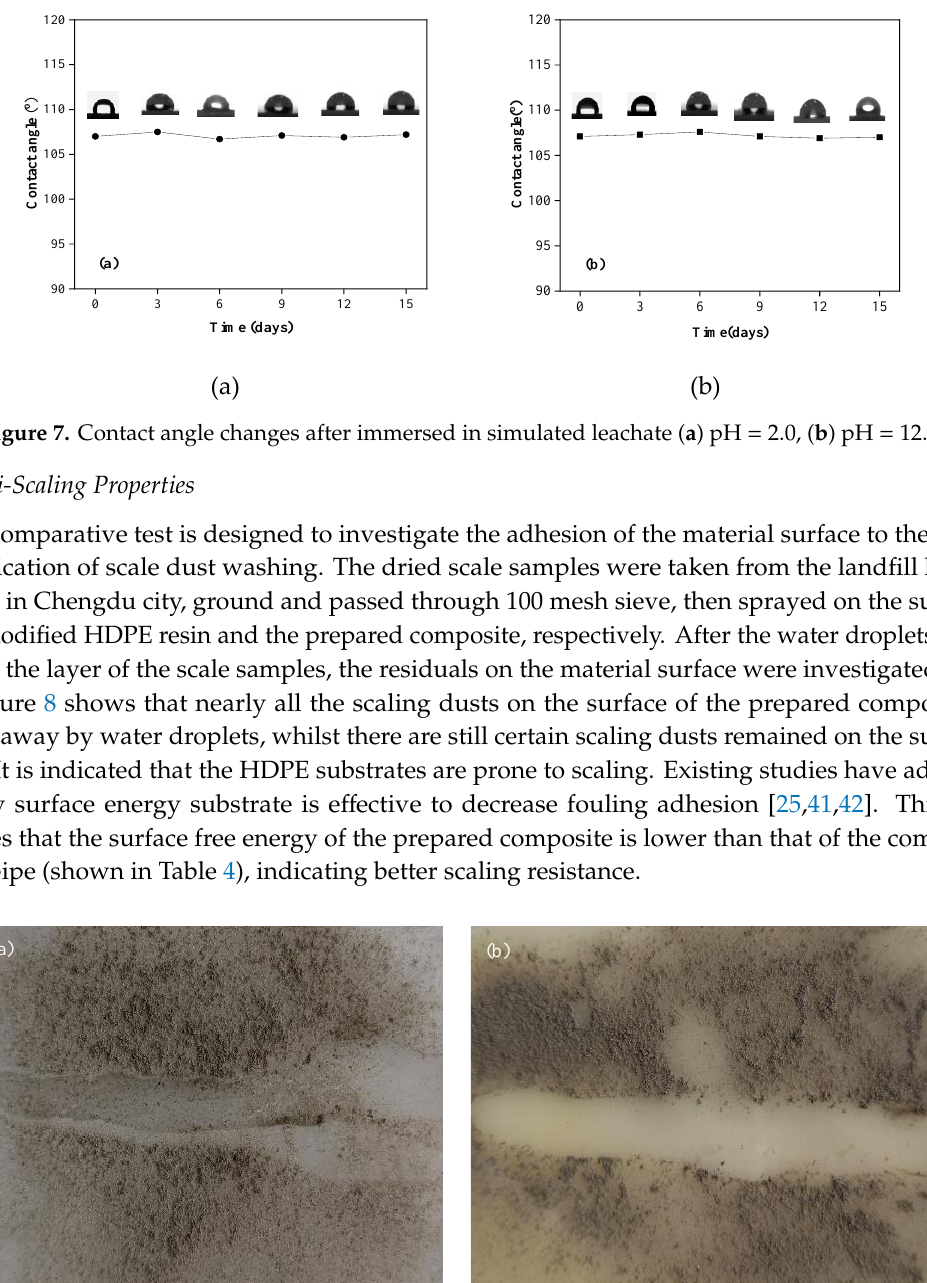
9 of 14 Figure 6. SEM images of different samples: ( a ) PSA10; ( b ) VTMO-SiO 2 ; and ( c ) HPS5. 3.5. Acid and Alkali Resistance